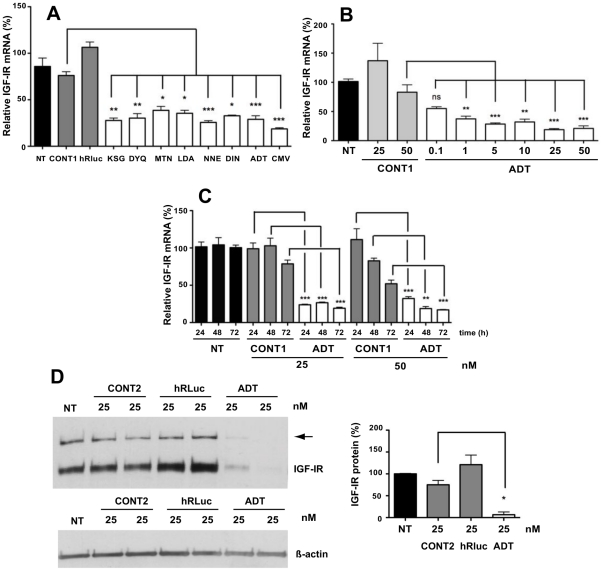
siRNAs targeted to mouse IGF-IR in breast cancer cells.(A) The effect of siRNAs (10 nM) designed against IGF-IR coding regions was measured by qRT-PCR 24 h post-transfection in EMT6 cells. (B) Dose-dependent inhibition of IGF-IR mRNA levels by ADT siRNA into EMT6. (C) Kinetics of silencing by ADT siRNA in EMT6 cells. Black bars represent mock transfected cells (NT). Means ± SEM of two independent experiments with independent transfected quadruplicates were shown; * P<0.05; ** P<0.01; *** P<0.001. Significant inhibition of IGF-IR mRNA by ADT persisted for 72 h at both concentrations, whereas 50 nM of CONT1 started to decrease significantly IGF-IR mRNA at 72 h when compared to untreated cells (P<0.001). (D) Western blot analysis after 48 h transfection of EMT6 cells with unmodified siRNAs. Arrows indicate the 200 kDa IGF-IR proreceptor. NT and black bars are non-transfected cells. Representative Western blot is presented and quantitative analysis of three independent experiments is shown next to the gel with means ± SEM. * P<0.05.